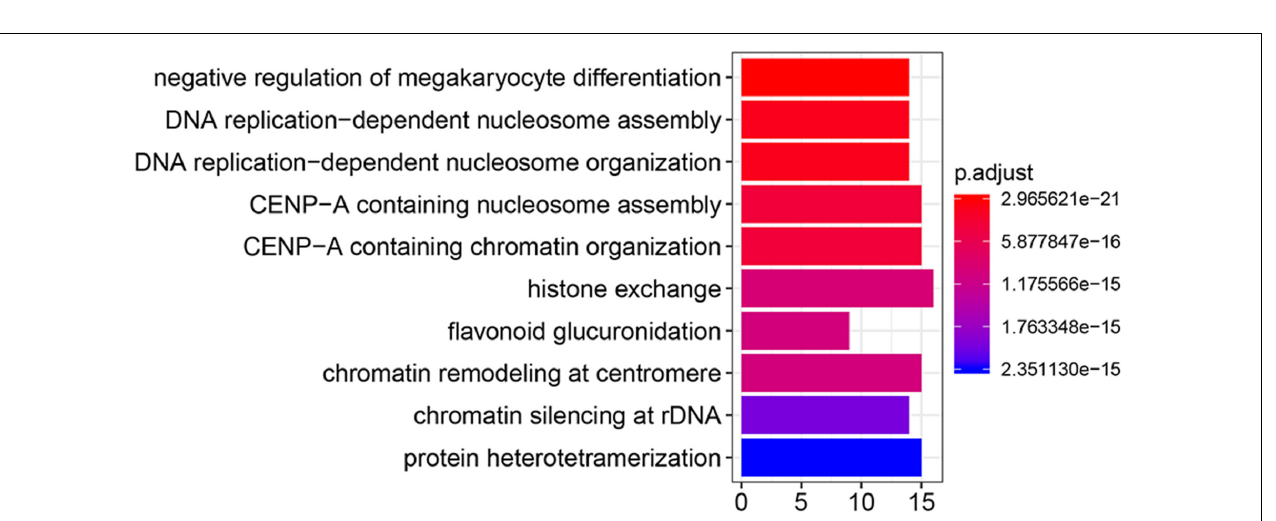
FIGURE 4 | Gene ontology enrichment analysis of differentially expressed